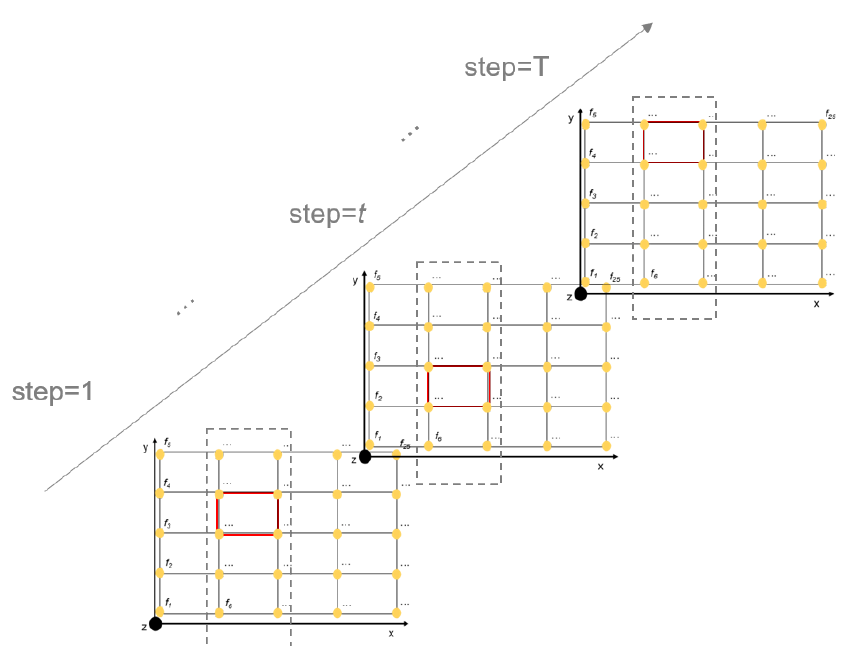
Figure 7. Exemplary determination of the approximative function value 𝑧 𝑡 = 𝑓 𝑎 (𝑥 𝑡 ,𝑦 𝑡 ) with a 5 × 5 resolution for multiple timesteps.